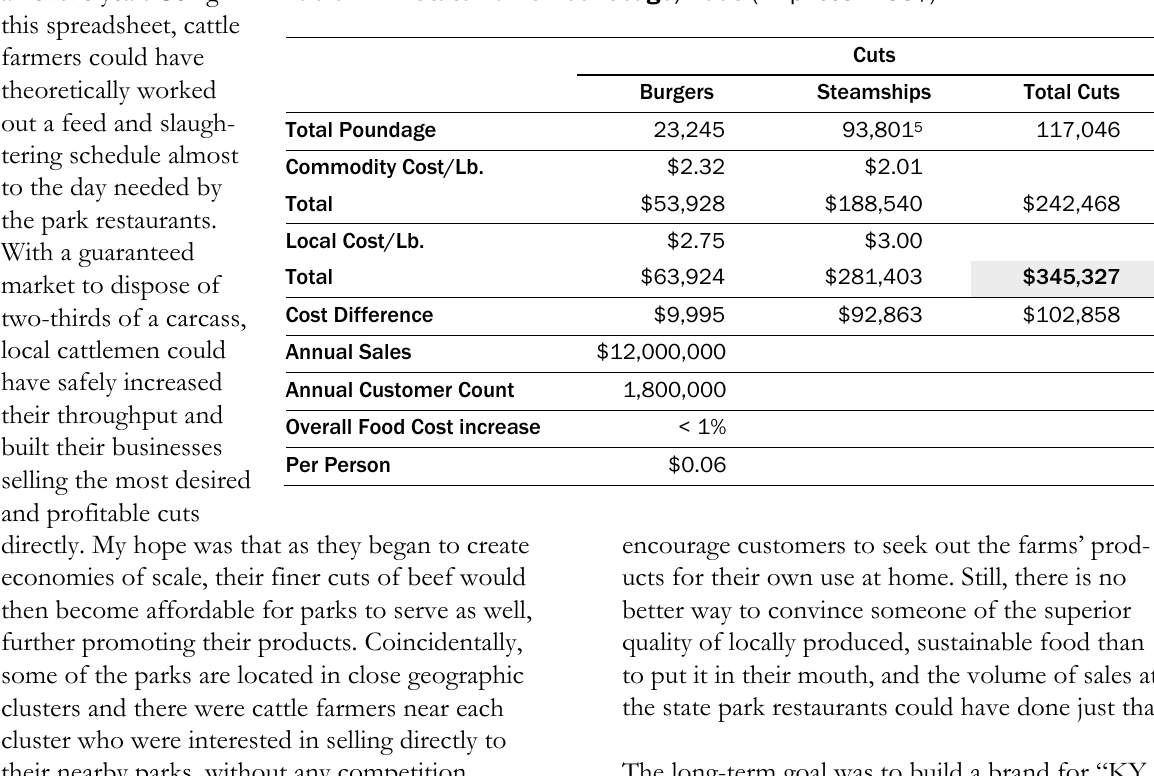
Table 1. KY State Parks Beef Usage, 2005 (All prices in